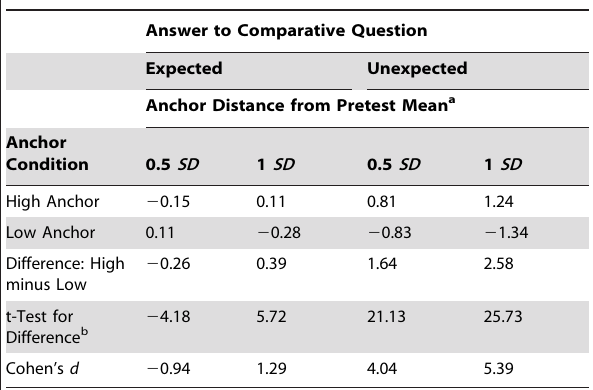
Table 2. Estimates by Anchor Condition, Anchor Distance, and Answer to Comparative Question (Study